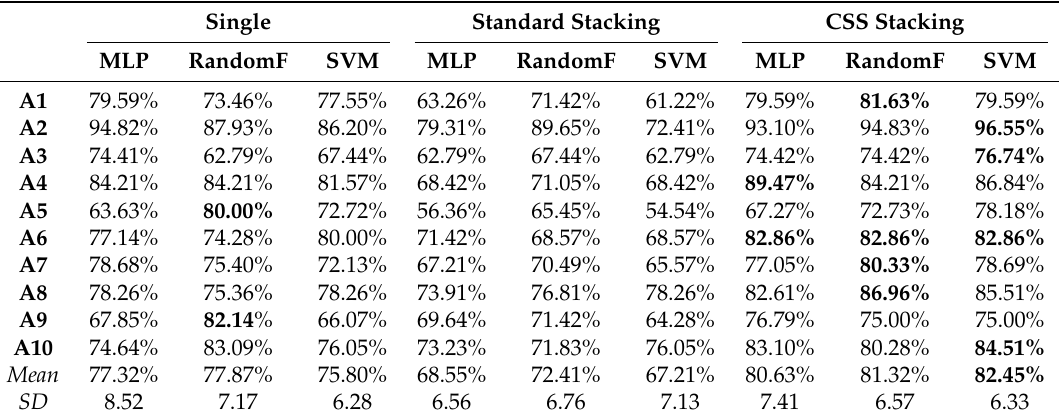
Table 9. Third phase. Accuracy percentages per actor for the best three classifiers of each system built on the Berlin Emotional Speech database (Emo-DB). Mean and SD rows represent the average and standard deviation considering all of the